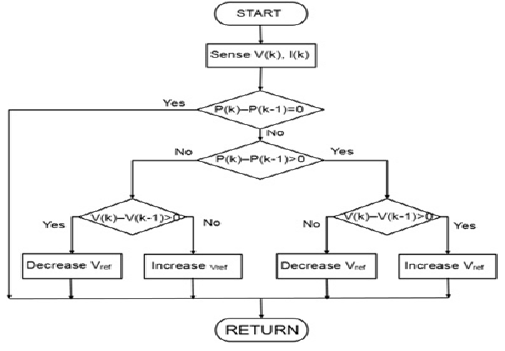
Fig. 6: Flowchart of conventional P&O algorithm.